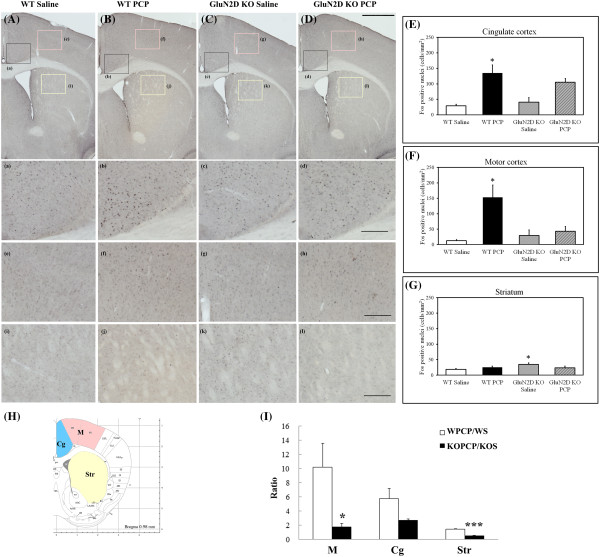
Analyses of Fos induction in various brain regions in wildtype and GluN2D knockout mice. The photomicrographs illustrate the immunohistochemical labeling of Fos in coronal sections of the forebrain. The boxes are shown in panels a-i are at higher magnification. A schematic representation of the cingulate cortex (Cg), motor cortex (M), and striatum (Str) is shown in panel H. The number of Fos-immunoreactive cells per square millimeter in PCP-treated mice was determined in the respective brain regions (E–G) and normalized to the number in saline-treated mice (I). Open bars, wildtype (WT) mice; closed bars, GluN2D KO mice. The results are expressed as the mean ± SEM ratio between the density of Fos-positive neurons in PCP-treated mice to the density of Fos-positive neurons in saline-injected mice (n = 4–6). One-way ANOVA of the PCP-induced increase in Fos-positive cells indicated a significant effect of genotype in the striatum (F1,6 = 75.8, p = 0.0001). *p < 0.05, ***p < 0.001. Scale bars = 1 mm and 200 μm in panel D and d, respectively. The brain regions are defined as indicated by the images in the atlas [10].